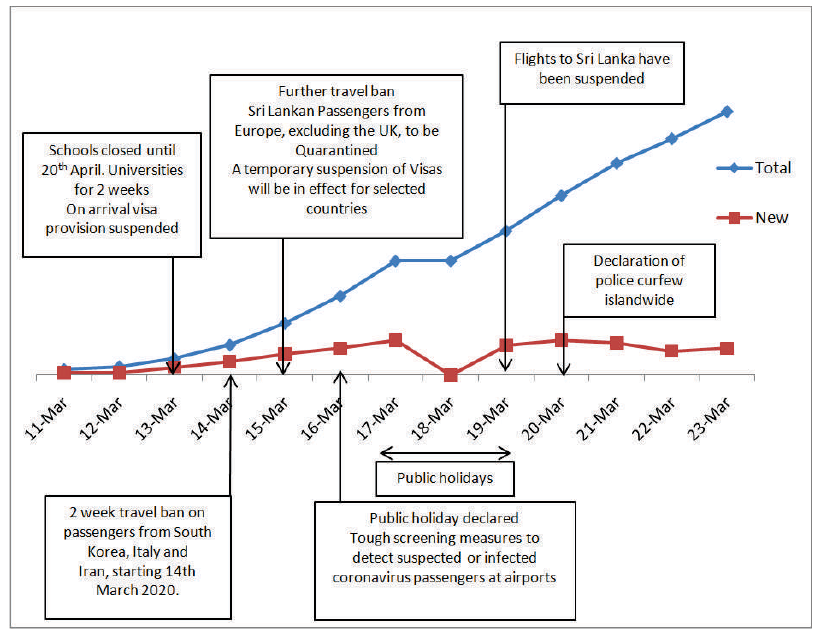
Figure 5: Interventions implemented to limit the spread of the